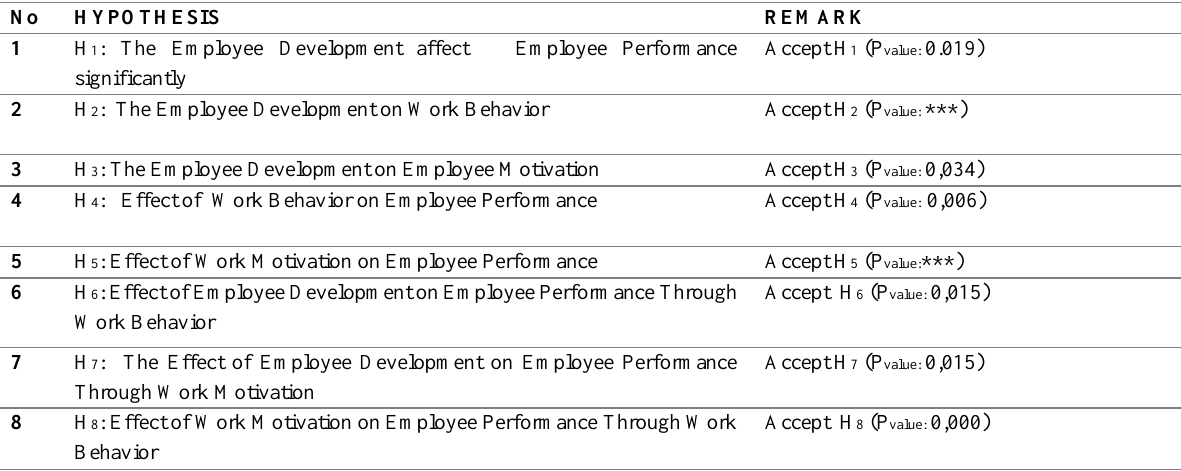
Table 5 : Recapitulation of Hypothesis Test